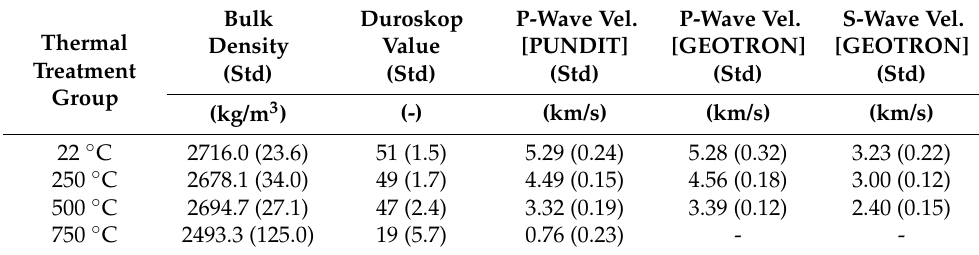
Table 3. Bulk density, Duroskop rebound value, P-wave velocity (PUNDIT and GEOTRON), and S-wave velocity (GEOTRON) results in heat-treated groups.